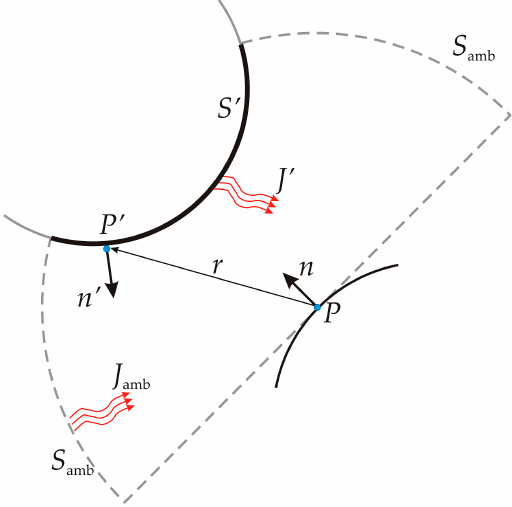
Figure 4. Geometry representation for surface-to-surface radiation.